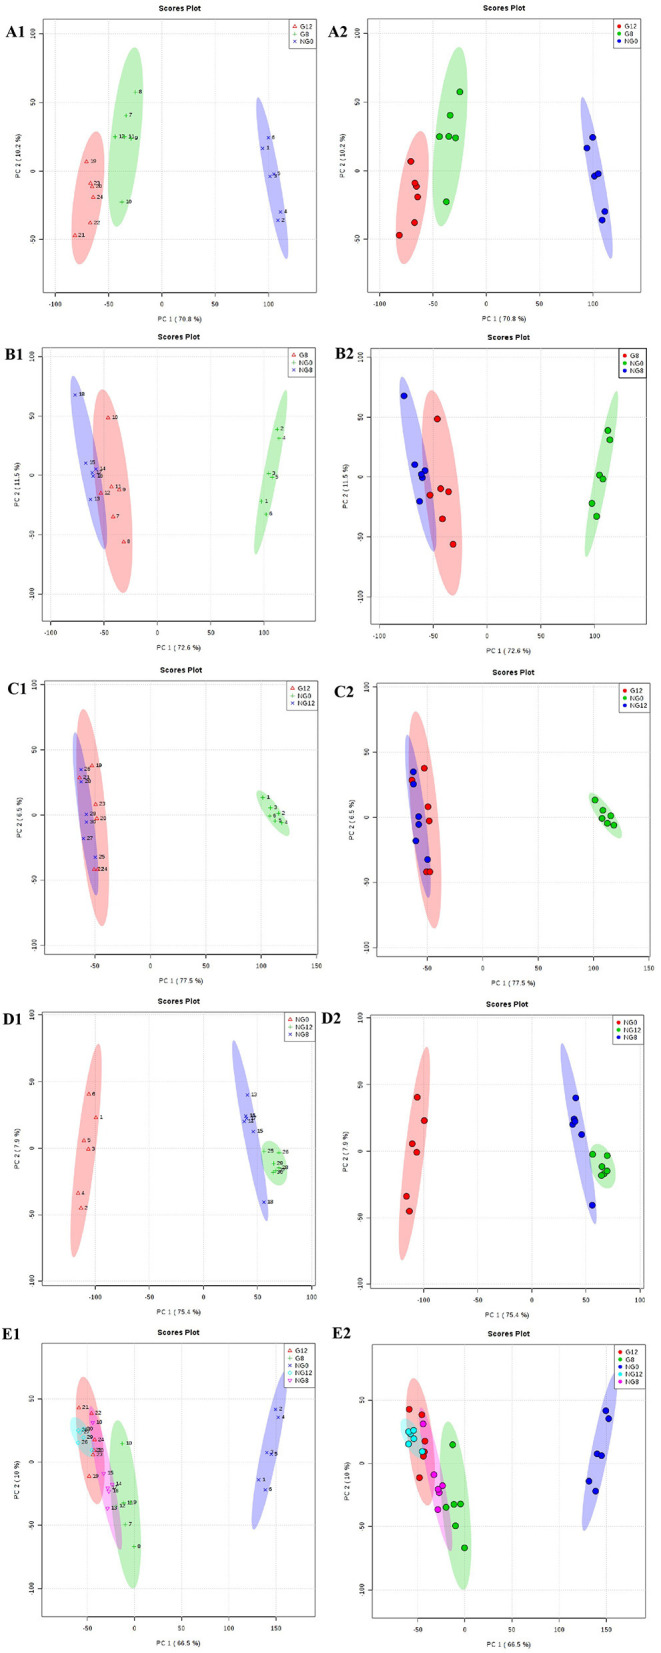
PCA score plots. (A1,A2) NG0-G8-G12; (B1,B2) NG0-G8-NG8; (C1,C2) NG0-G12-NG12; (D1,D2) NG0-NG8-NG12; (E1,E2) G8-G12-NG0-NG8-NG12. The middle point represents the sample number, and the contribution rate of PC1 and PC2 in the score chart is shown. The area within the middle ellipse represents the 95% confidence interval.